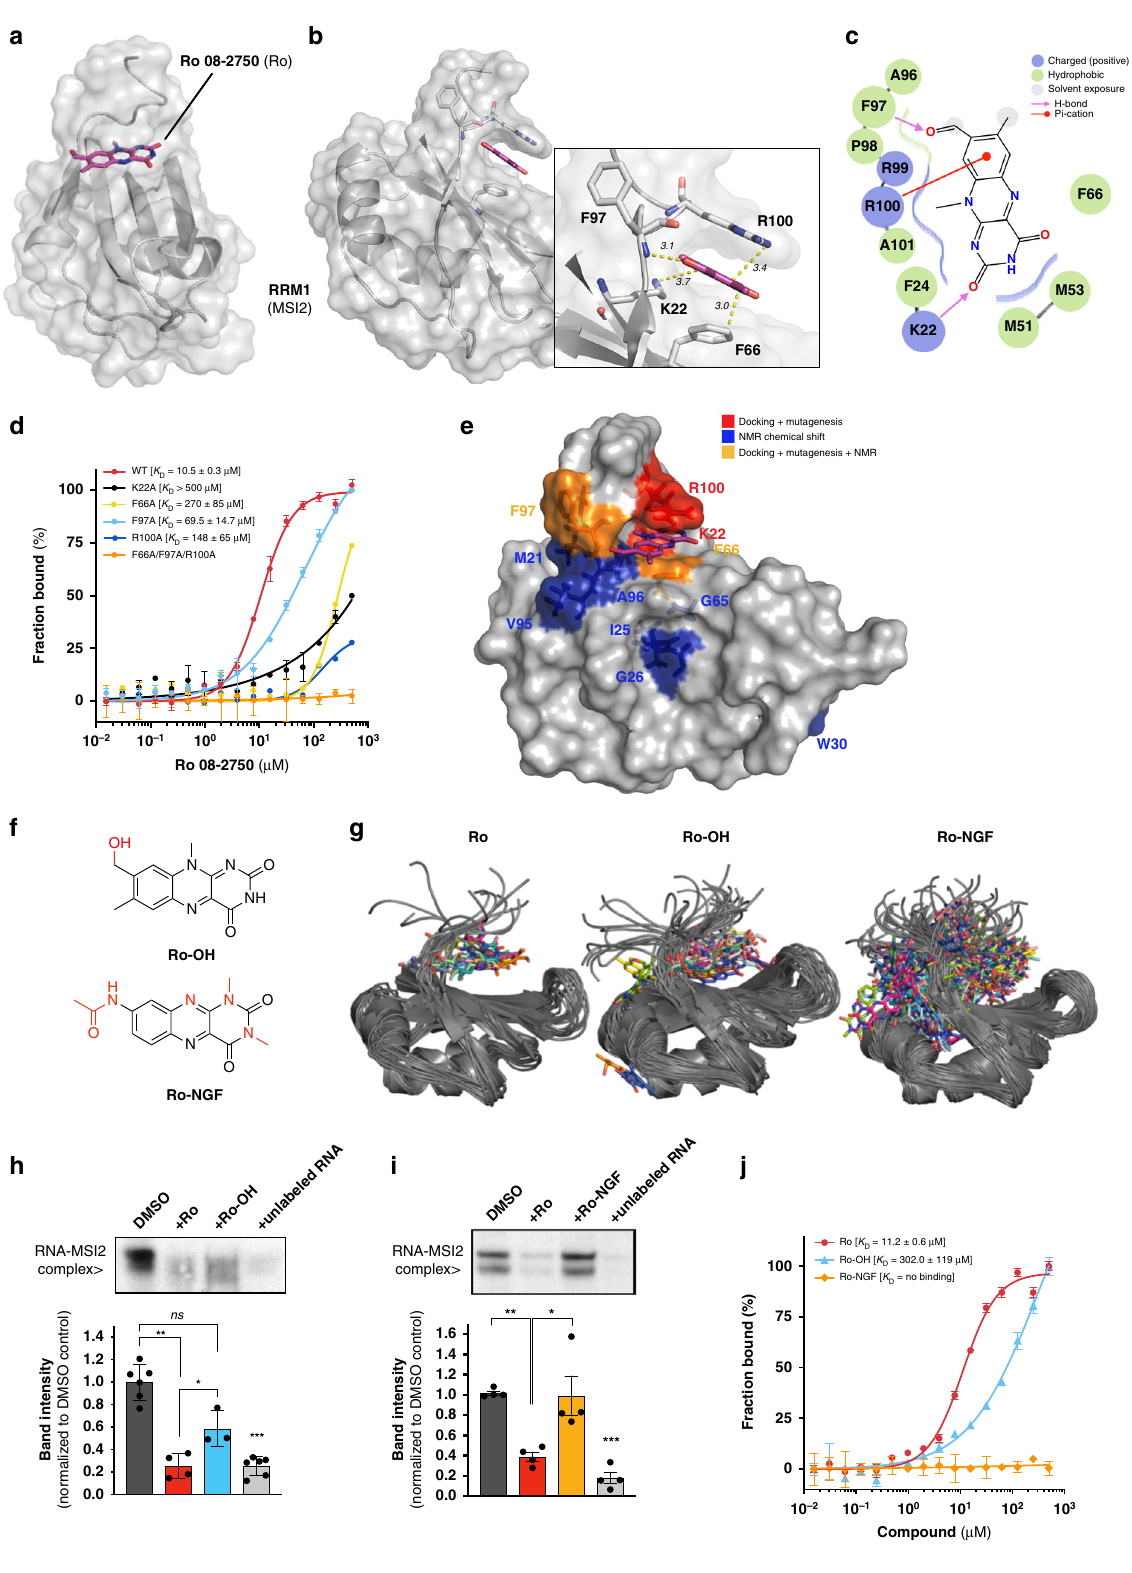
(RNA-IP with FLAG) experiments on K562-MIG (empty vector) and K562-FLAG-MSI2 (MSI2 overexpressing) cells (Fig. 5a). By incubating the drug at 10 μ M ( ∼ EC 50 ) for 1 h with the cells, we could detect a signi fi cant decrease in MSI2 mRNA binding targets ( TGFBR1 , c-MYC , SMAD3 , CDKN1A ) (Fig. 5b). These data